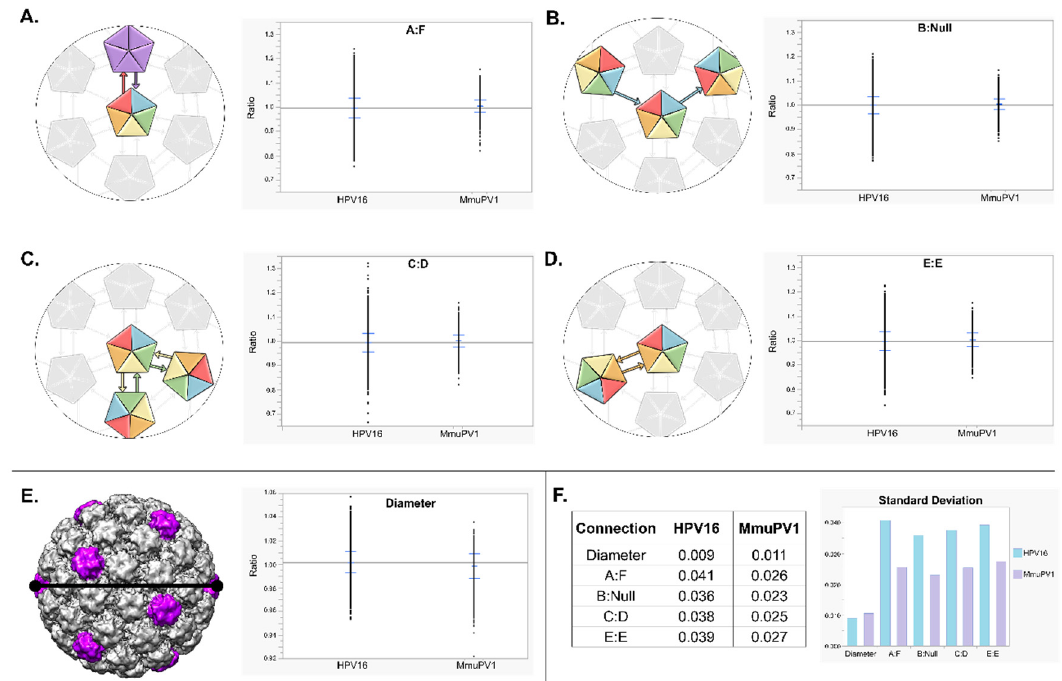
Figure 6. Intercapsomer and diameter distances of MmuPV1 and HPV16 QV. ( A – D ) Intercapsomer distance comparisons. ( A – D , left) Cartoon depiction of the intercapsomere connections, A:F, B:null, C:D, and E:E, respectively. ( A – D , right) Graphical representation of intercapsomere distances for all qualifying particles. For all intercapsomere distances HPV16 QV had a much wider spread of data with ratios ranging from 0.7 to 1.3, while MmuPV1 had ratios ranging from 0.8 to 1.2. ( E , left) Cartoon depiction of the entire icosahedral virus showing the diameter is measured between two polar-opposite pentavalent capsomers (purple). ( E , right) Graphical representation of diameter distances for all qualifying particles. HPV16 QV had a more even spread of the data with ratios ranging from 0.95 to 1.05, while MmuPV1 had ratios ranging from 0.94 to 1.04. ( F ) Standard deviation comparison between all measurement types for HPV16 QV and